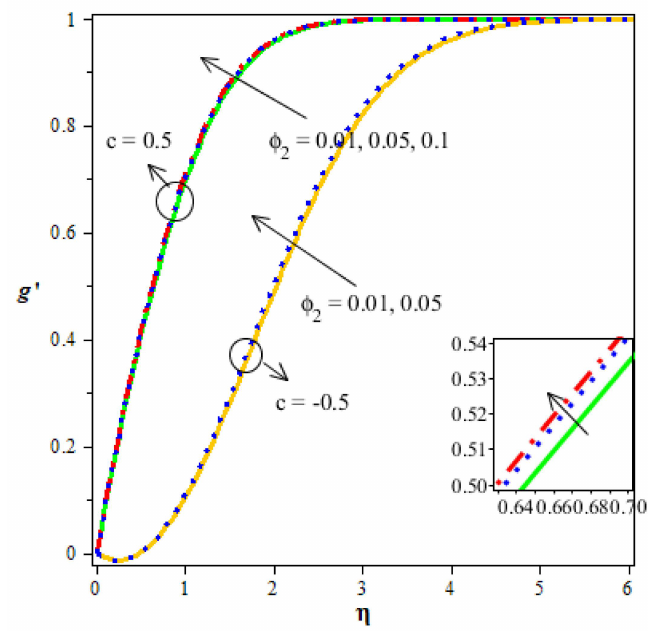
Figure 8. The curve g (cid:48) ( η ) on φ 2